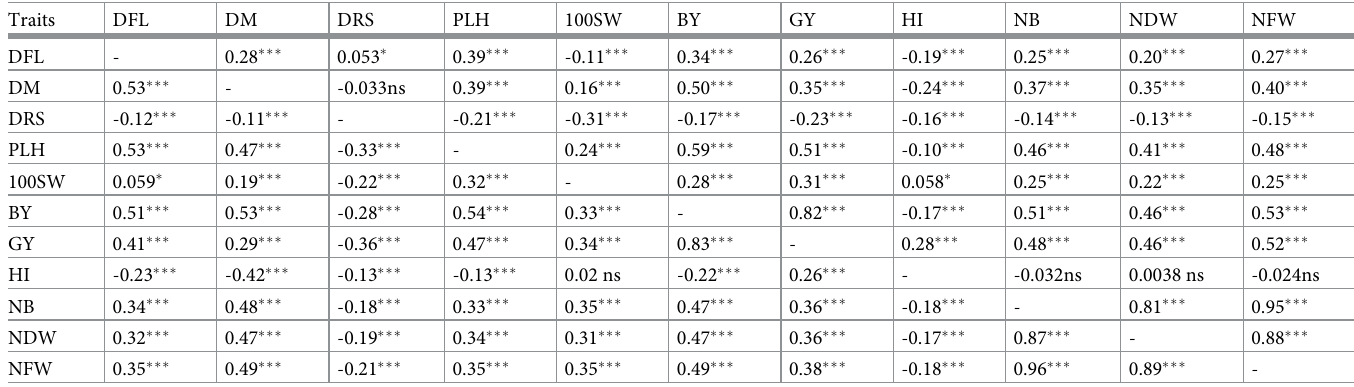
Table 4. Phenotypic correlation coefficients between different morphological and yield components in chickpea under drought and irrigated conditions.